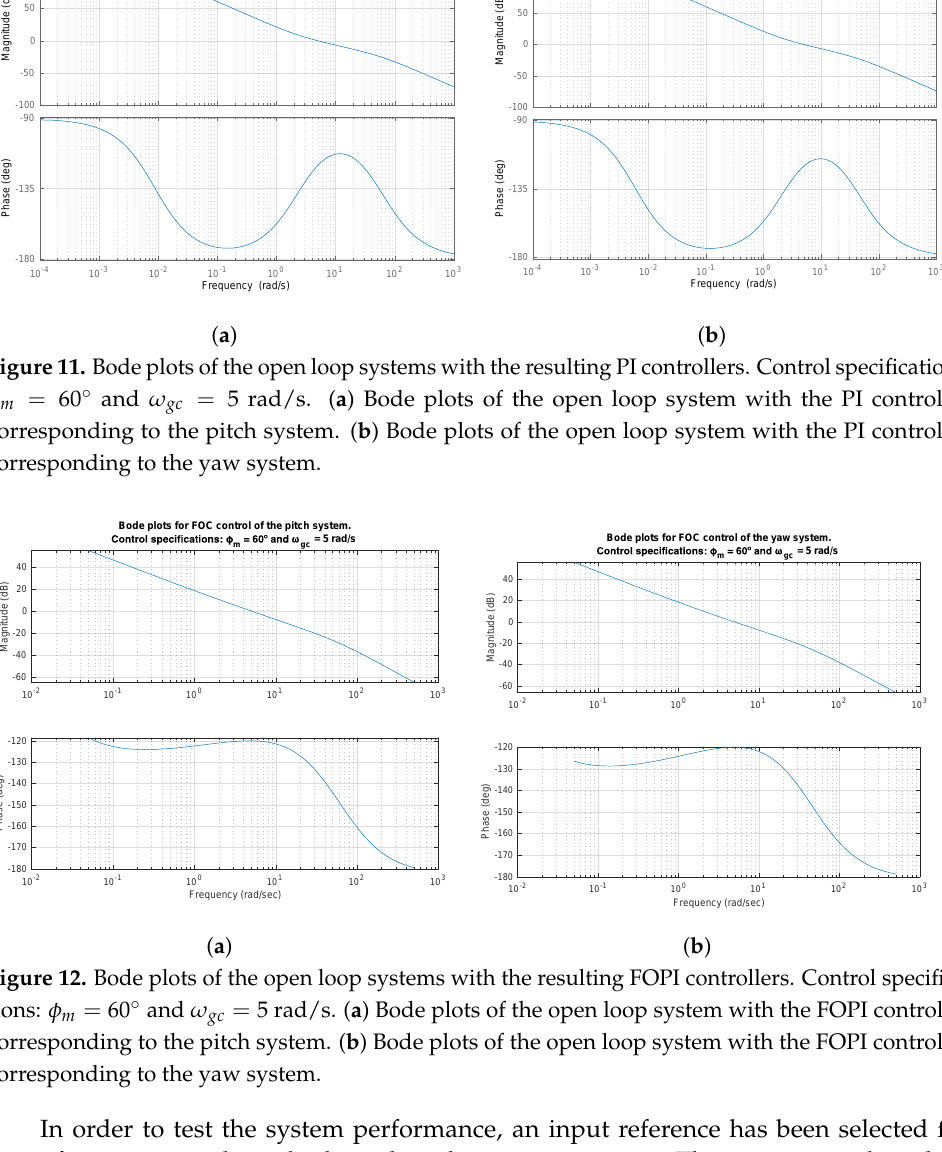
Bode plots for PI control of the yaw system. m